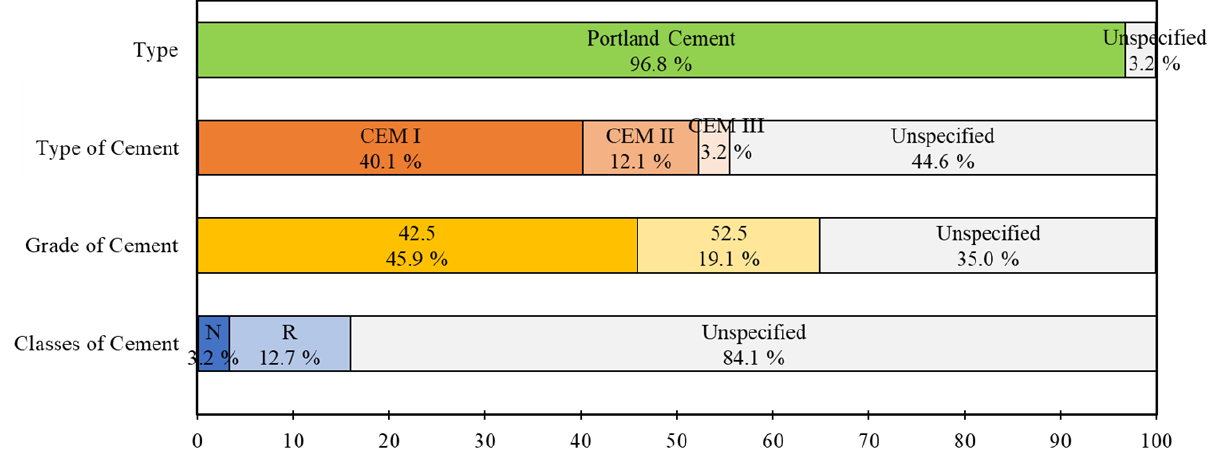
Figure 10. Type, type of cement, grade of cement, and class of cement for 157 3DCP mixtures design (%) (data source: [30,44 – 85,89 – 92]). (%) (data source: